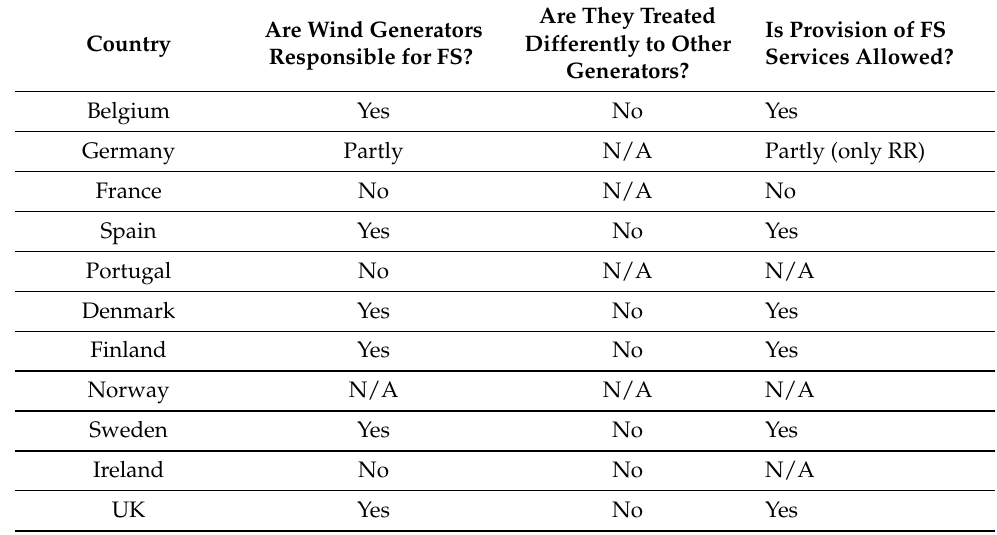
Table 7. Frequency support responsibility of wind power generators according to EWEA’s survey. Are They Treated Is Provision of FS Are Wind Generators Differently to Other Country Services Allowed? Responsible for FS? Generators?